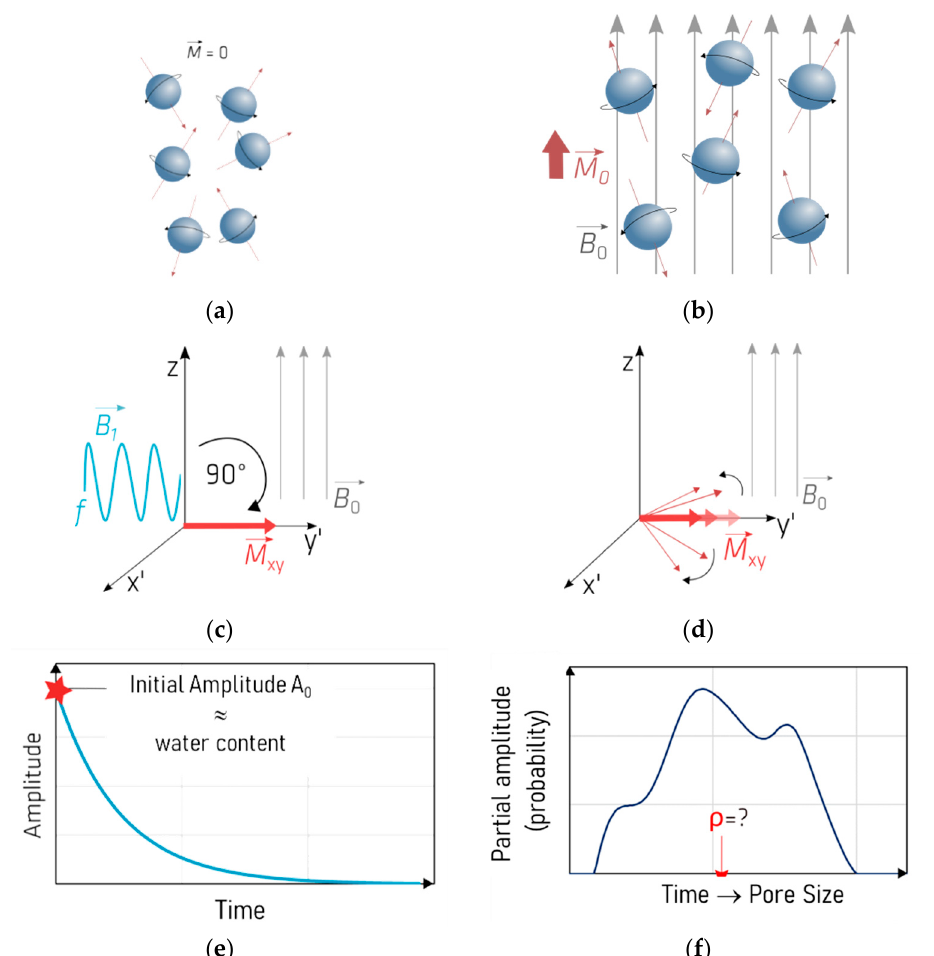
Figure 4. NMR Principles, adapted version from [5]. ( a )—Initial state in a water ‐ containing medium without magnetization. ( b )—Alignment of the protons when the sample is exposed to a static magnetic field. ( c )—Deflection of the resulting magnetization into the transverse plane (x ‐ y) by a short radiofrequency pulse. ( d )—The magnetization relaxes back into the equilibrium state after termination of the radio ‐ frequency pulse. ( e )—Resulting measurable NMR signal (exponential decay of NMR amplitude). ( f )—Relaxation time distribution as a result of a numerical inversion of the measured decaying signal. When converted using a material constant ρ , the x ‐ axis can be converted to pore sizes.